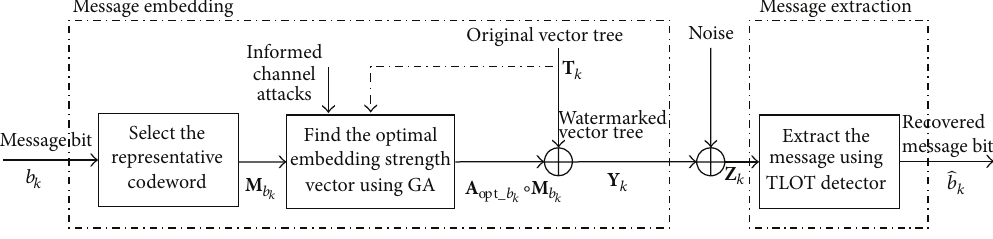
Figure 2: Block diagram of watermark embedding and extraction processes in [21]. The GA, “ ∘ ,” and TLOT denote the genetic algorithm, element-wise multiplication, and Taylor-series-approximated locally-optimum test, respectively.